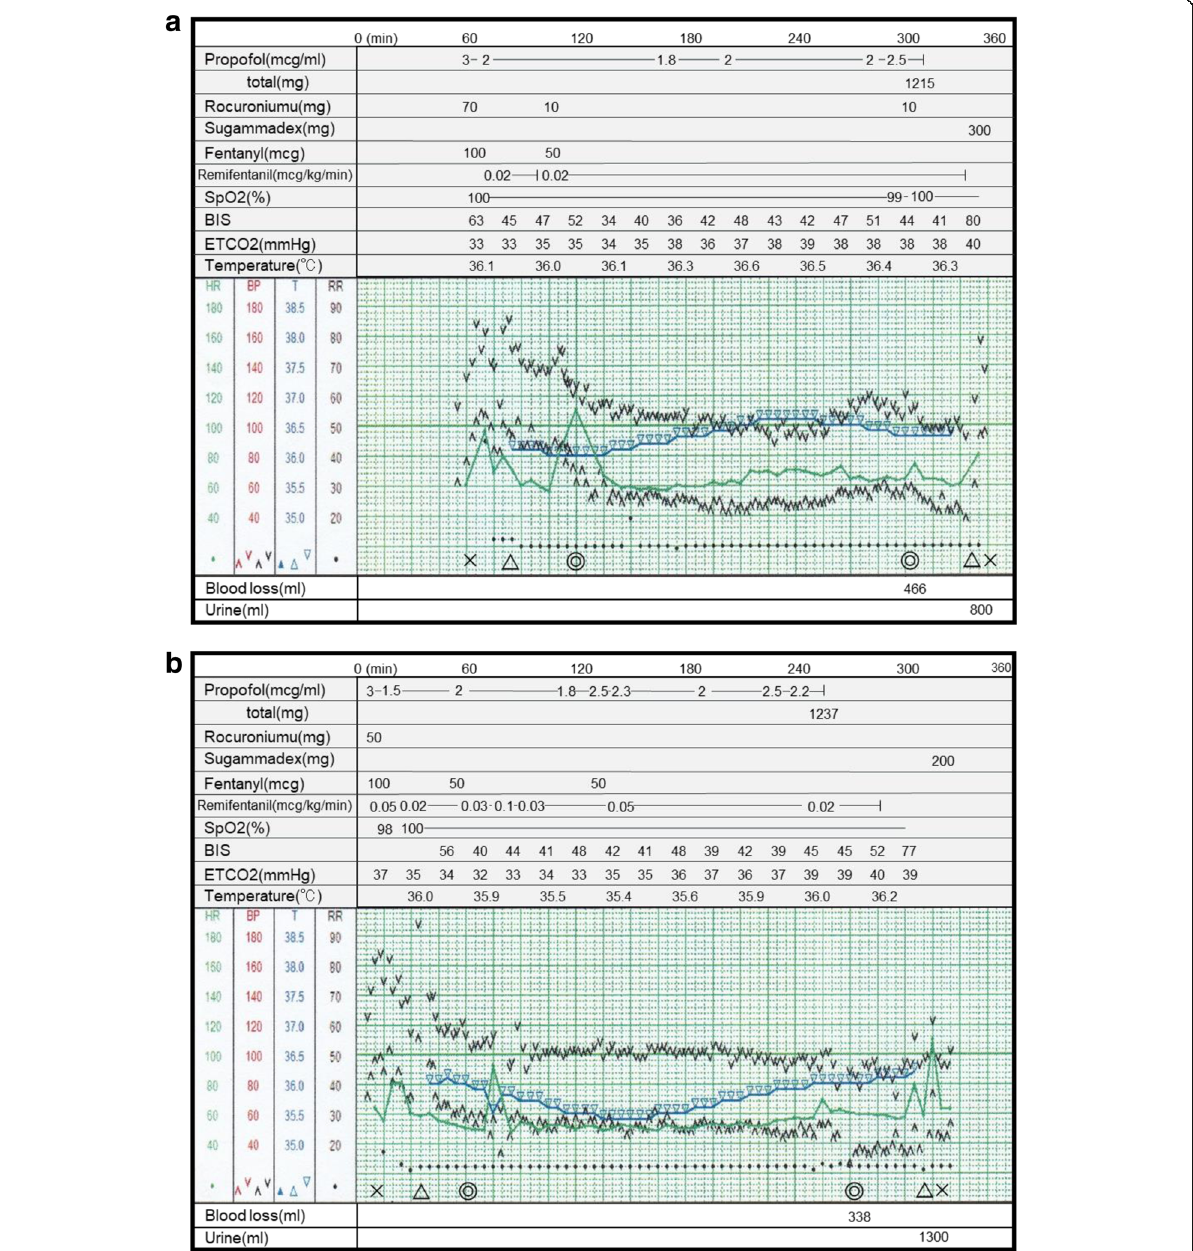
Fig. 1 Anesthetic charts of the first operation ( a ) and the second operation ( b ). X represents the start and finish of anesthesia, △ represents the intubation and extubation, and ◎ represents the start and finish of surgery. SpO 2 , O 2 saturation of the pulse; BIS, bispectral index; ETCO 2 , end- tidal